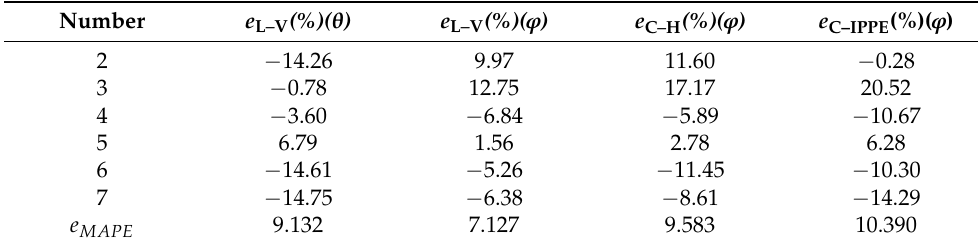
Table 5. Measurement error of (𝜃, 𝜑) .